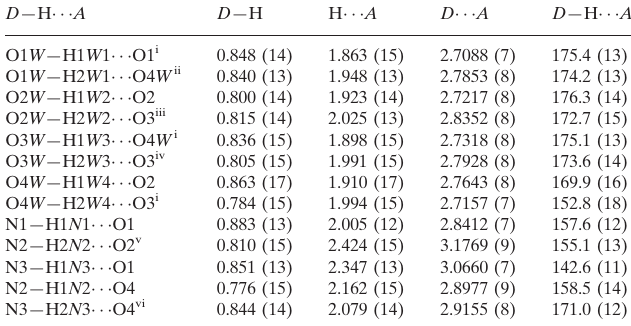
Hydrogen-bond geometry (A˚ , (cid:5)